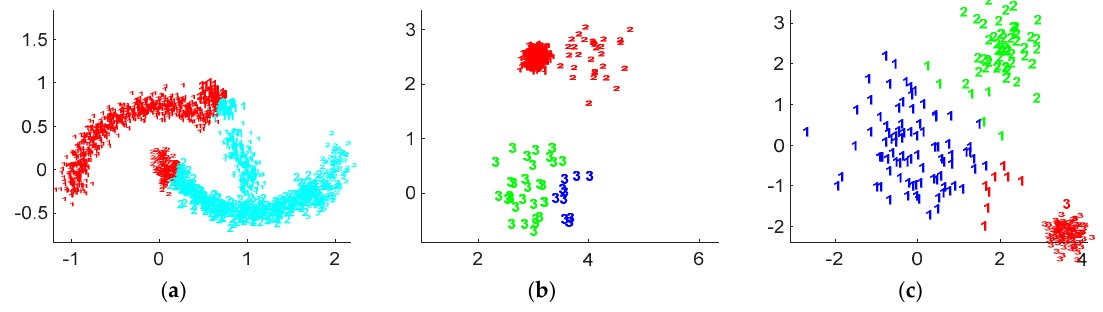
Figure 2. Three datasets with different characteristics and the clustering results by using density peak-point-based clustering (DPC), Density-Based Spatial Clustering of Applications with Noise (DBSCAN) and C-means: ( a ) two nonspherical clusters; ( b ) three density-different clusters; ( c ) three partially-overlapped clusters.